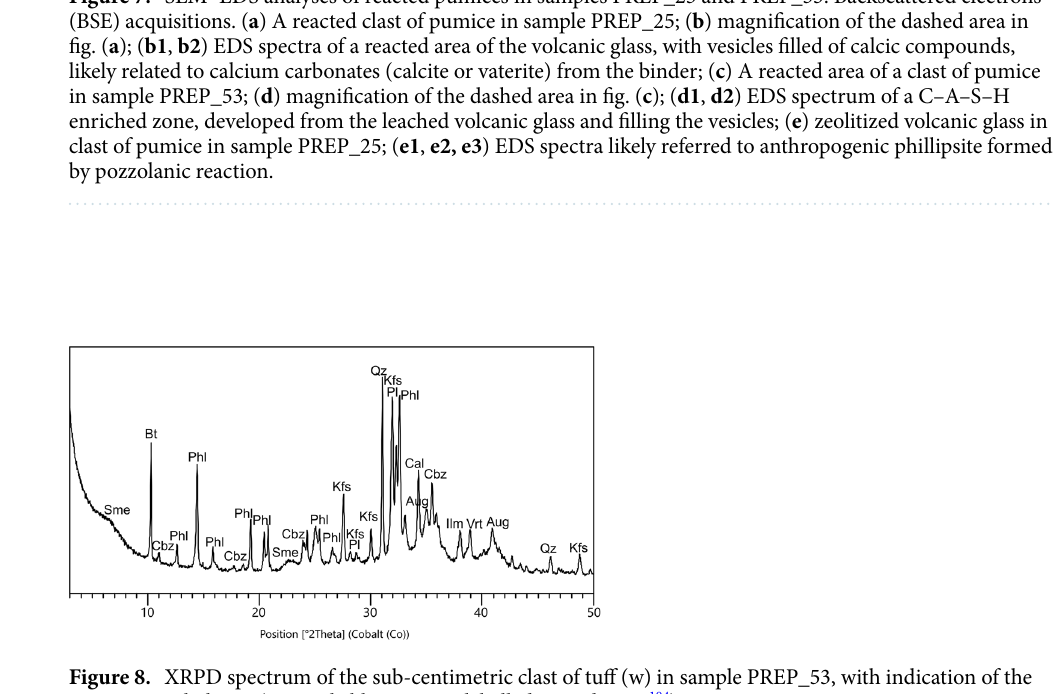
Figure 8. XRPD spectrum of the sub-centimetric clast of tuff (w) in sample PREP_53, with indication of the main mineral phases (mineral abbreviations labelled according to 104